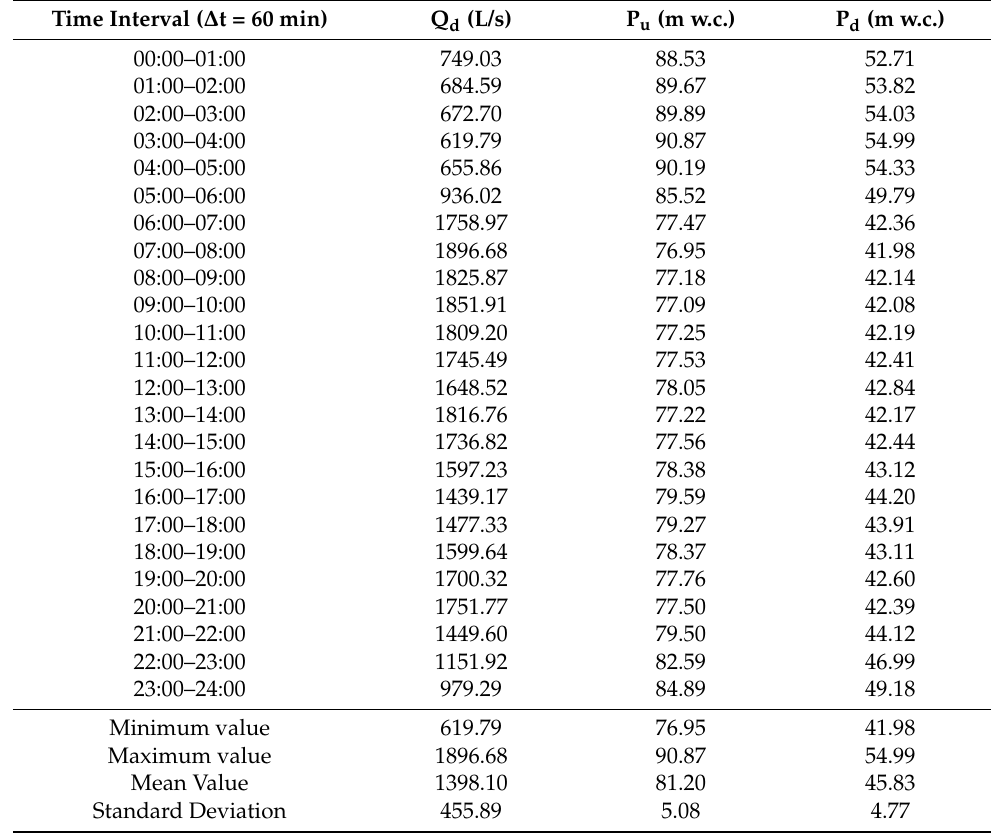
two deposits, and the flow is established between them. Table 1. Data recovered from the case Table 1. Data recovered from the case study.